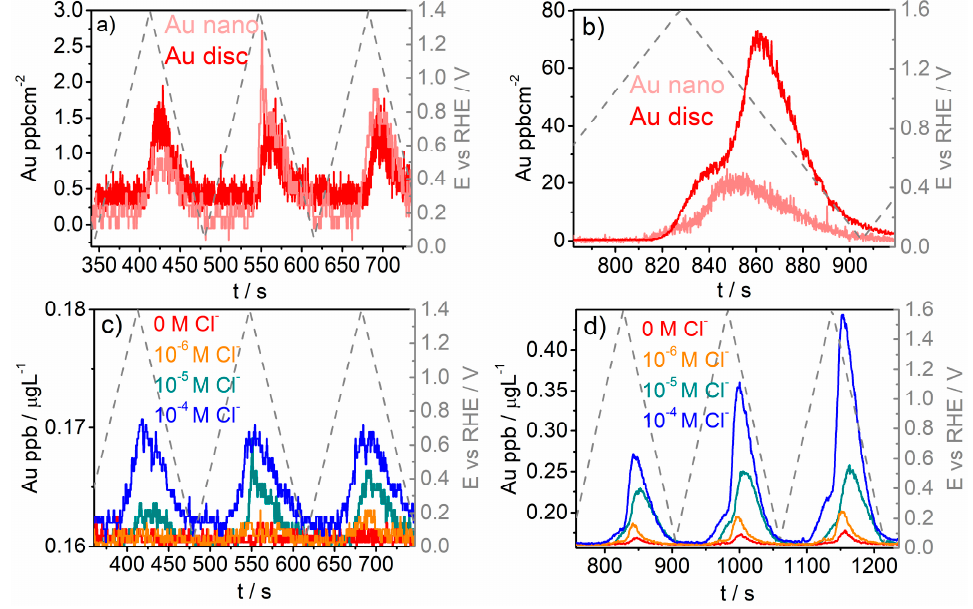
Figure 4. EFC-ICP-MS measurements of Au dissolution from Au nanoparticles in the absence ( a , b ) and presence of chlorides ( c , d ) during potentiodynamic cycles (20 mV·s − 1 , 0.05–1.4 or 1.6 V RHE ).